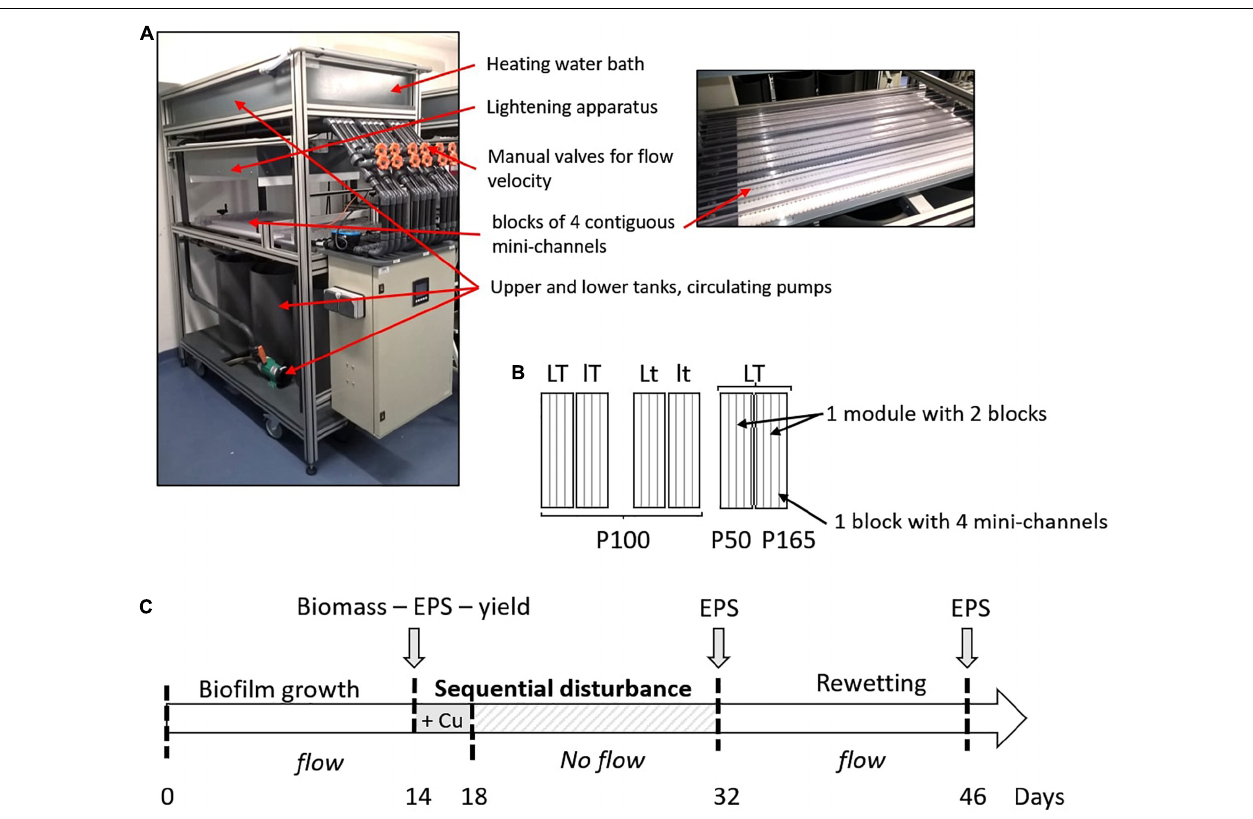
FIGURE 1 | (A) Photographs of one module with a detail view of the mini-channels. (B) Experimental design applied for the two biofilms. The experimental conditions were the same in the four mini-channels of one block. Six different conditions were tested with two levels of temperature ( T = 22 ◦ C or t = 19 ◦ C),